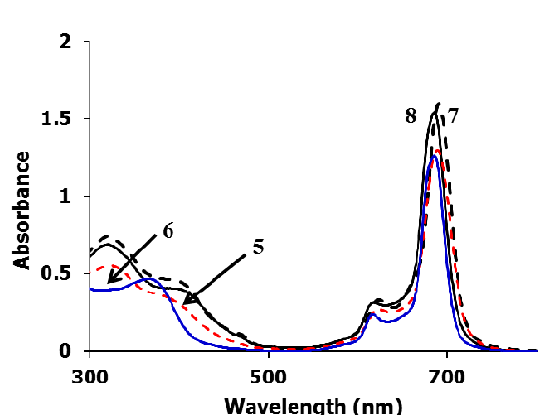
Figure 4. Ground state electronic absorption spectra of 5 , 6 , 7 and 8 in DMSO (Concentration ~ 1×10 −5 mol dm −3